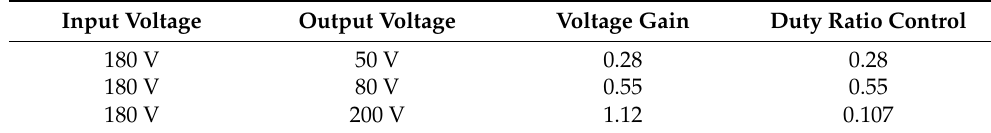
Table 2. Required voltage gain or duty cycle ratio to obtain the required output.